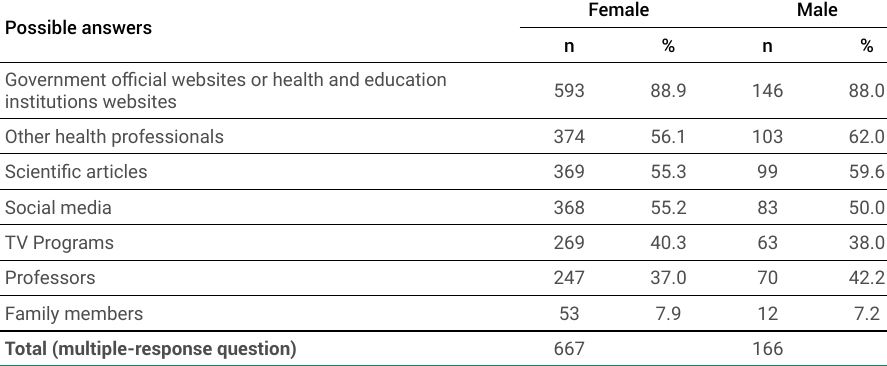
Table 1. Dental students’ source of information about COVID-19 by gender Possible answers